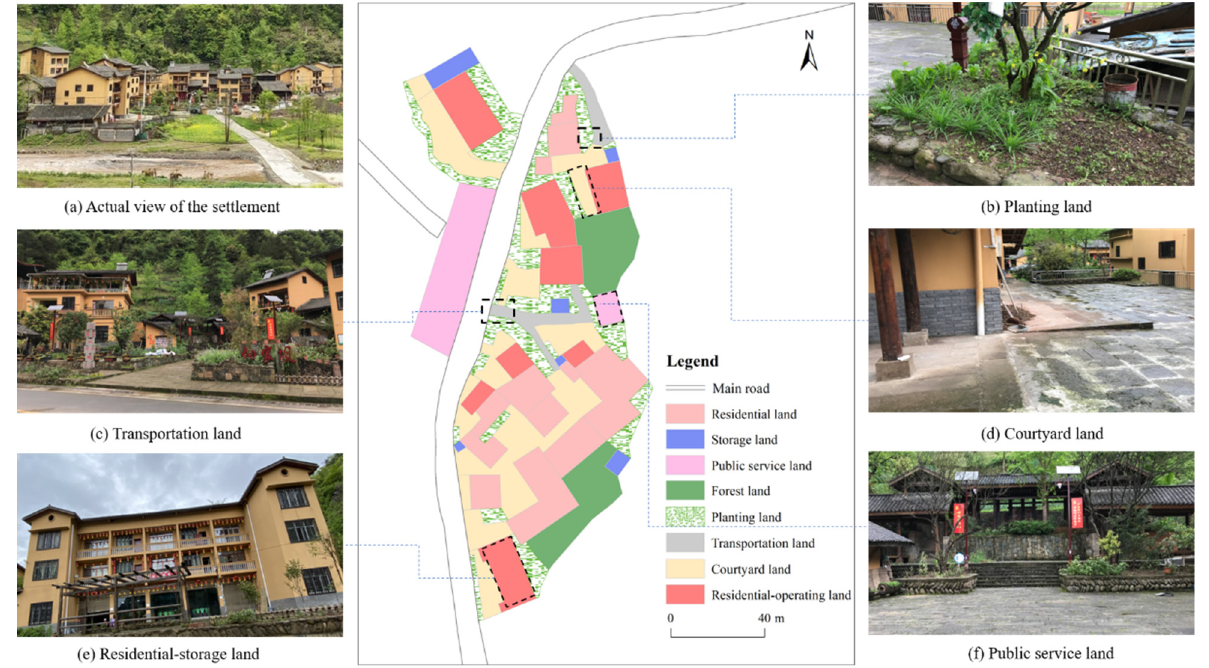
Figure 5. Schematic diagram of the structure of the MLU in settlement No. 14 (Xiangjiaba Homestay).